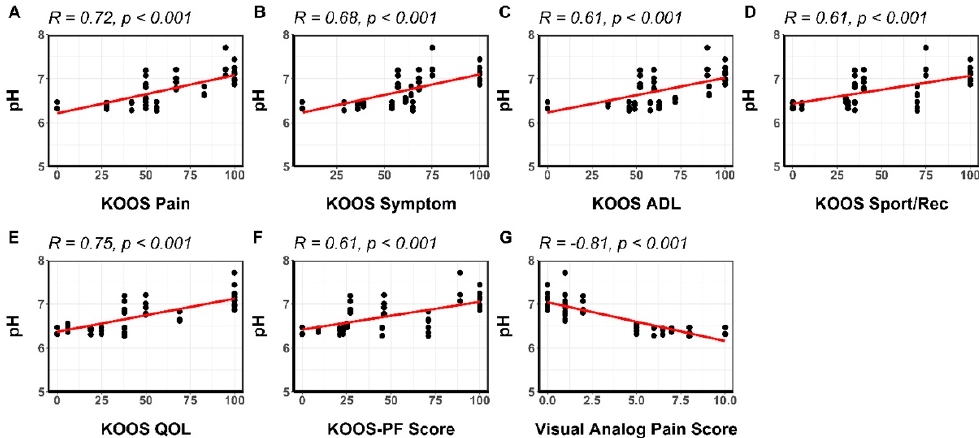
Figure 5. Scatterplots of pH versus KOOS scores and the visual analog pain score. Strong direct correlations were observed for all KOOS subscale scores ( A – F ). There was a strong inverse correlation between pH measurements and the visual analog pain score ( G ). KOOS: Knee Injury and Osteoarthritis Outcome Score; ADL: activities of daily living; Sports/Rec: sports and recreation activities; QOL: quality of life; PF: patellofemoral.